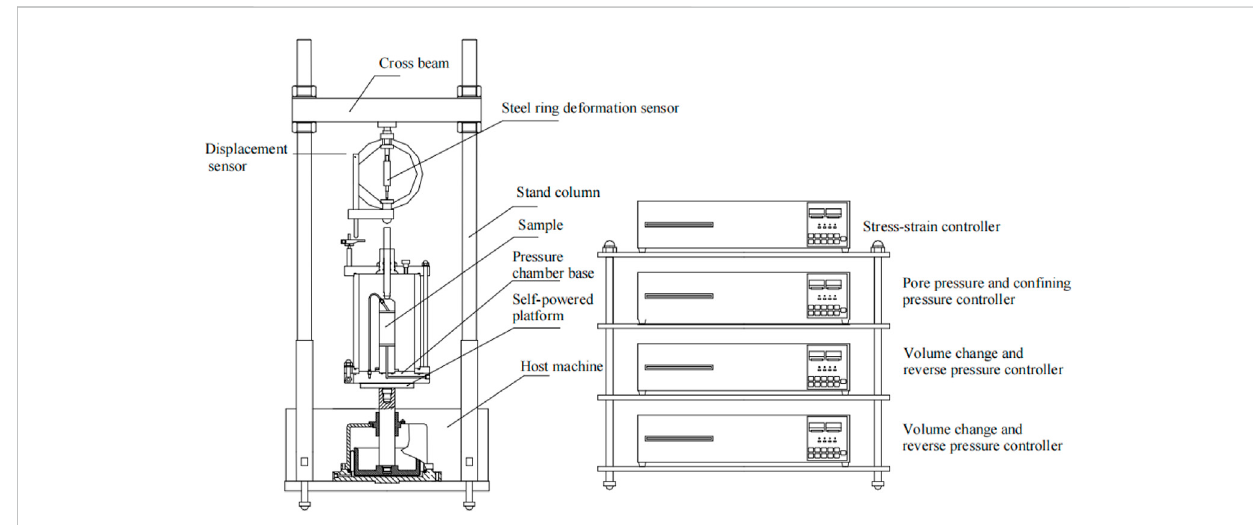
FIGURE 2 SLB-1A stress-strain controlled triaxial shear